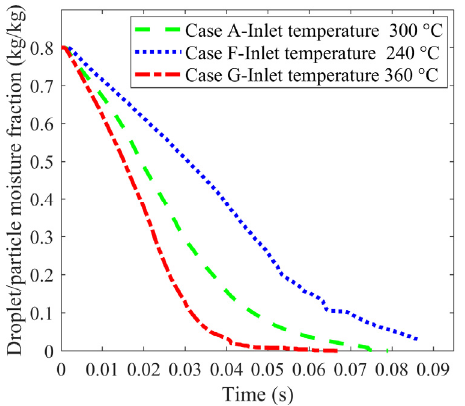
Figure 13. Mass loss curves for typical particle diameter of 37 µm for three different air inlet tem-